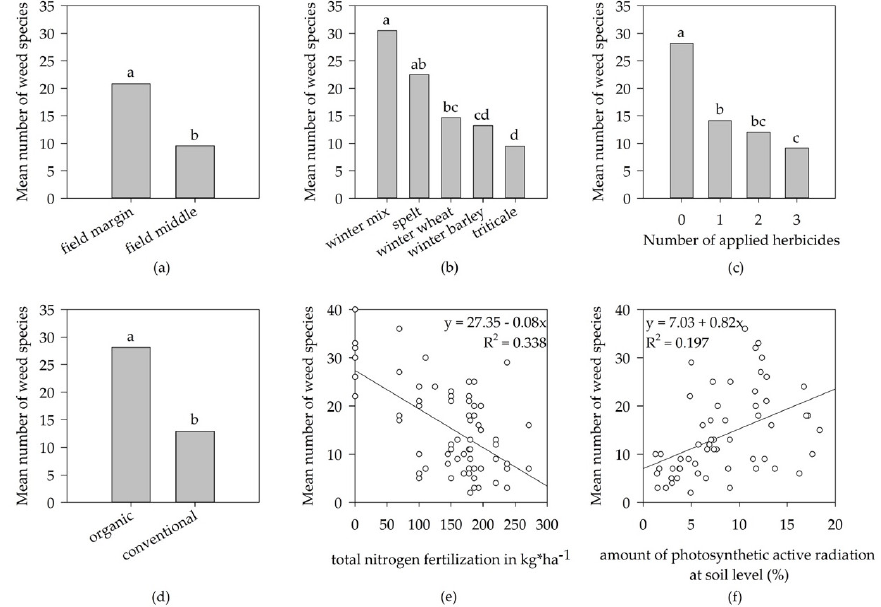
Figure 1. Factors influencing the mean number of weed species in the Gäu region ( a ) location in the field; ( b ) crop species; ( c ) number of applied herbicides; ( d ) farming system; ( e ) total nitrogen fertilization (y = 27.35 − 0.08x; R 2 = 0.338); and ( f ) amount of photosynthetic active radiation at soil level (y = 7.03 + 0.82x; R 2 = 0.197). Means with different letters represent significant differences according to the Tukey HSD test ( p ≤ 0.05).